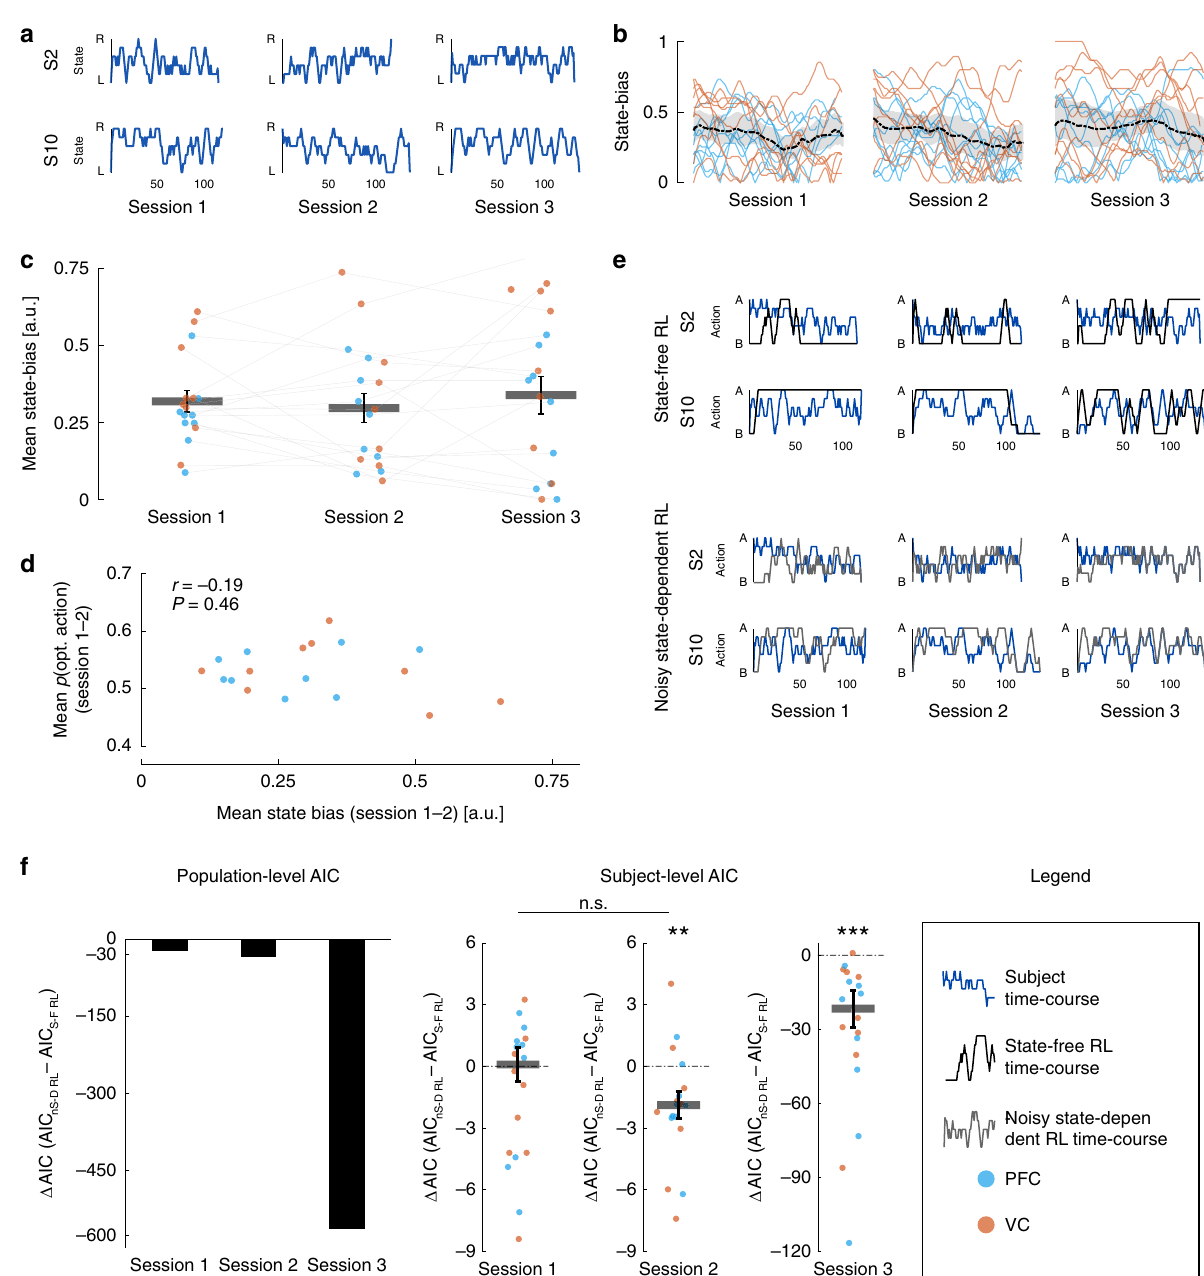
Fig. 3 Latent state bias and computational learning models. a Example state time-courses, for each session, from two subjects. R and L denote the two possible states (decoder outputs). Each line represents trial-by-trial decoded outputs smoothed with a moving average fi lter (span = 5 trials). b Individual traces of the extent of latent RL state bias throughout each session. Latent state bias was de fi ned as the unsigned difference between the number of occurrences of each state, normalized by the number of trials. Time-courses were computed with a moving window (span = 30 trials), and then smoothed with a moving average fi lter (span = 5 trials). The black dotted lines indicate the group mean, the shaded areas the 95% con fi dence intervals, coloured lines individual subjects. c Individual and group average of the degree of absolute latent state bias as outputted by the decoder, for each session. d Mean latent state bias plotted vs. mean p (opt action), averaged over sessions 1 – 2. Pearson correlation ( n = 18), two-sided p value. e Example time-courses of actions selected by two subjects (blue lines) vs. actions selected by the two RL algorithms that were fi tted to the data. Top, black lines: state-free RL model. Bottom, grey lines: noisy state-dependent RL model. f Akaike Information Criteria (AIC) 31 was computed for each subject, session and model, respectively. Lower AIC indicates a better fi t. Left: bars show the difference in AIC between the two models: AIC sd − AIC sf . Δ AIC < 0 on all sessions, indicating lower AIC for the noisy state-dependent RL. Right: subject level and median Δ AIC for each session. Within-session statistical test against 0: full linear model, with the intercept as difference from 0 (two-sided p values, FDR corrected). Between-session statistical test of difference (sessions 1 vs. 2): sign test (one-sided p value, uncorrected). In c , d , f , coloured dots represent individual subjects; in c , f , thick horizontal lines represent the mean and the median, respectively, error bars the SEM. The experiment was conducted once ( n = 18 biologically independent samples). f n.s. P = 0.42, ** P = 0.0085, *** P =